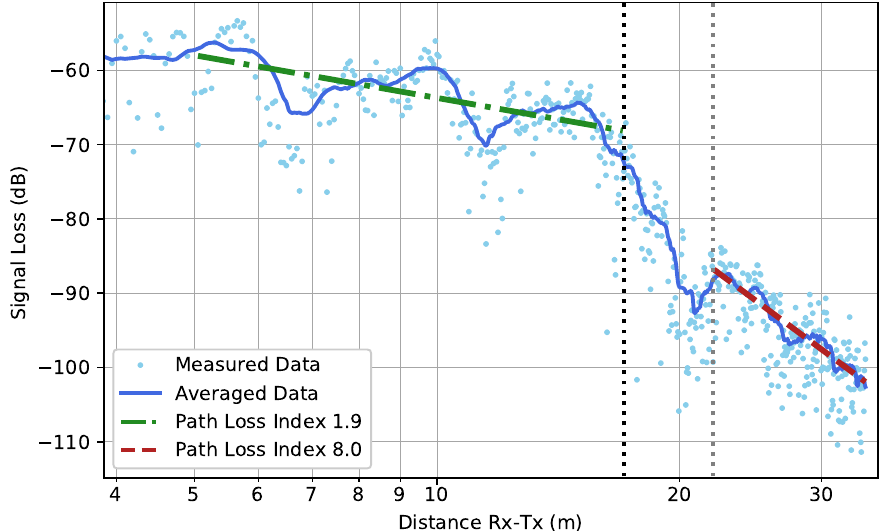
Figure 12. Scenario WOC: The high-resolution measured data together with their averaged values ( solid line ) according to Equation (3). The black dotted line illustrates the position of the corner within the path. The dotted grey line is the point at which the far-zone behavior resumed. Firstly, the path loss was fitted ( dash-dotted line ) on the data until the corner was reached and, secondly, the path loss was fitted ( dashed line ) when the far-zone behavior